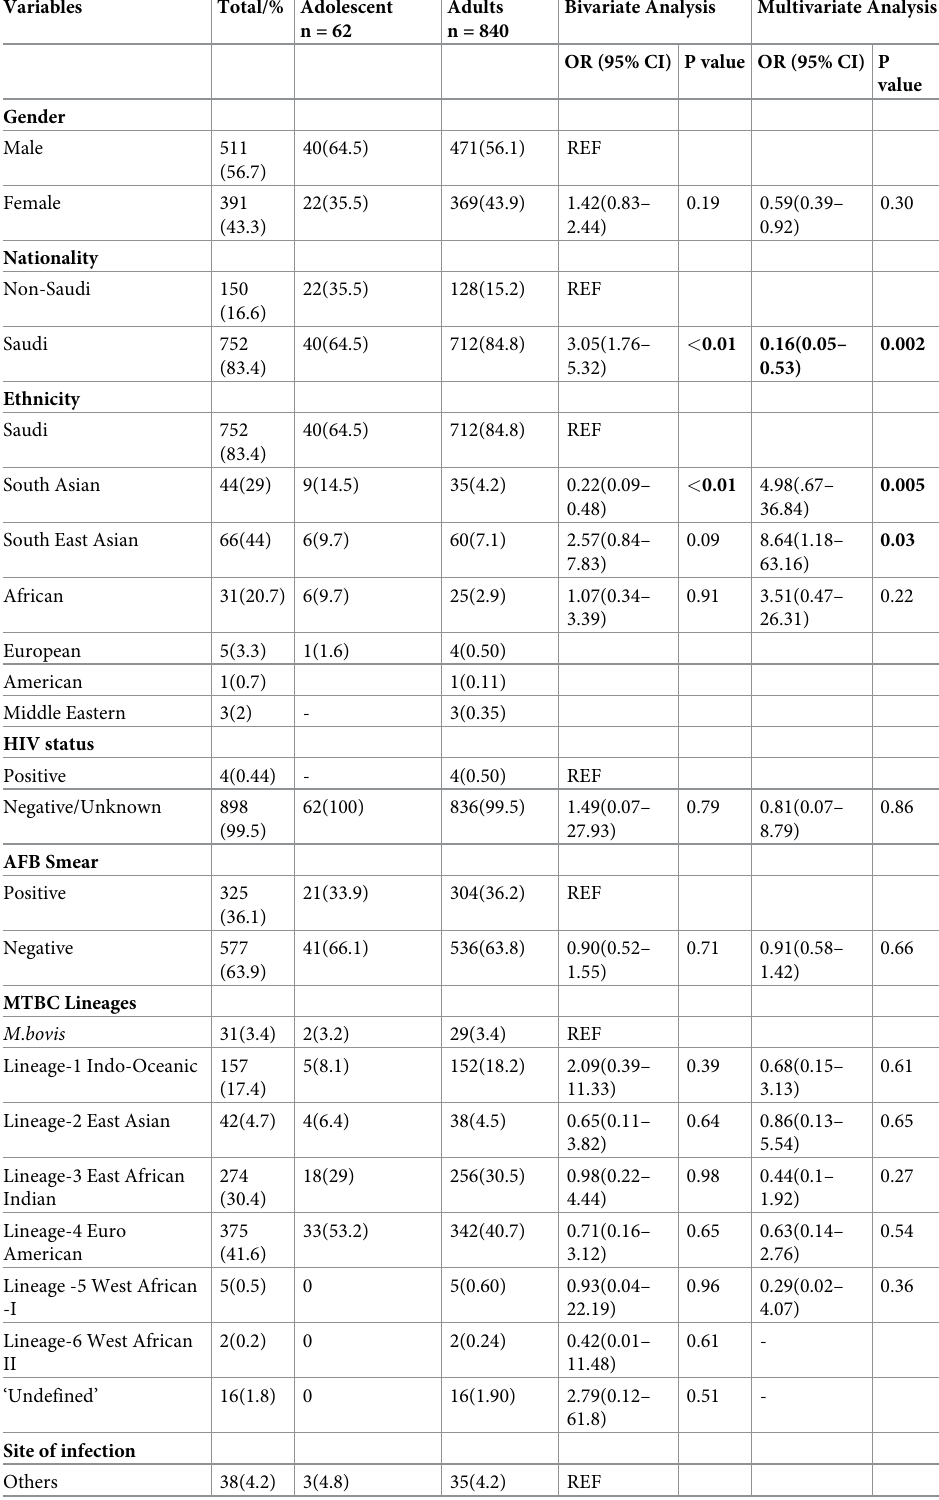
Table 3. Association of demographical and clinical risk factors among adult and adolescents EPTB